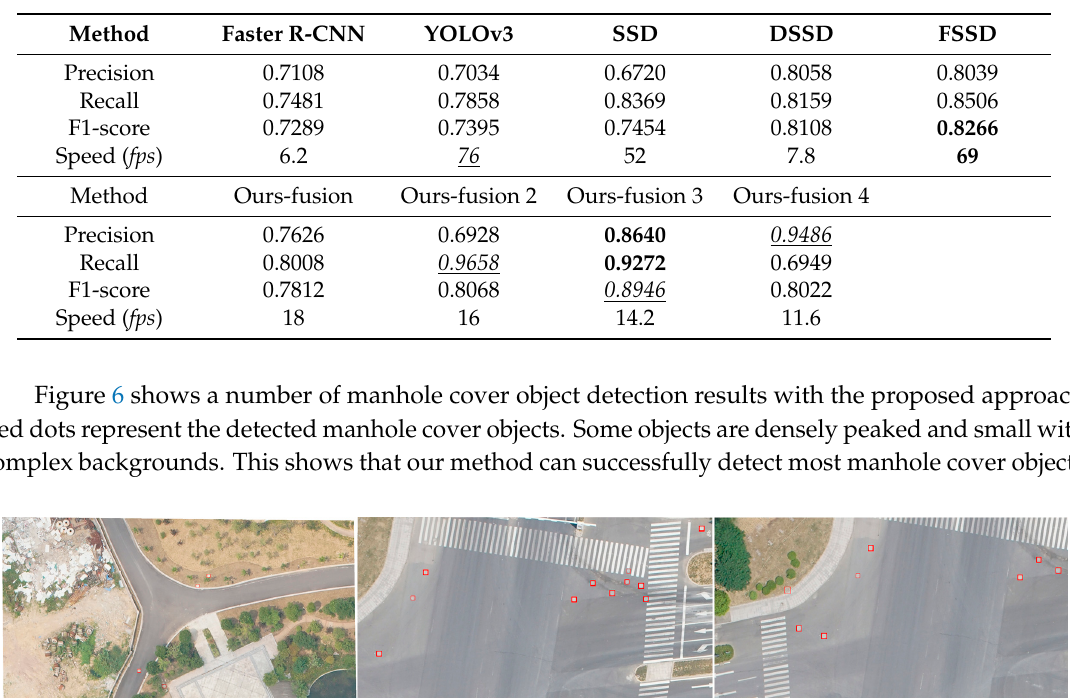
Table 3. Performance comparisons of nine different methods in terms of Precision, Recall and F1-score. The italic underlined numbers denote the optimal values in each row. The bold numbers denote the suboptimal values in each row. Ours-fusion is the result of object detection using only the fusion layer (as illustrated in Figure 1) and Ours-fusion2 is the fusion result of the manhole cover appearing twice in the six layers of side-output1, side-output2, side-output3, side-output4, side-output5 and fusion; Ours-fusion3 and Ours-fusion4 can be deduced in turn.